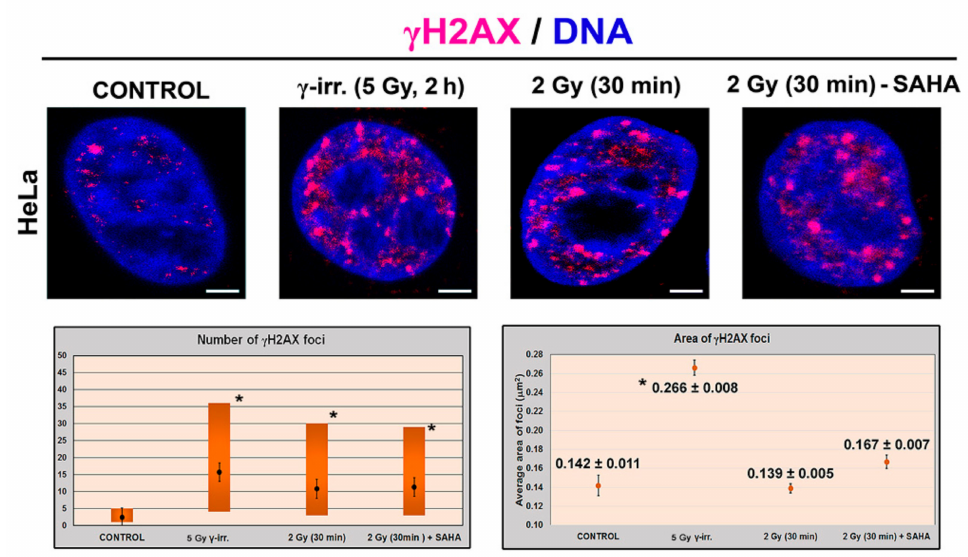
Figure 9. E ff ects of γ -irradiation by 5 Gy of γ -rays, SAHA treatment, and a combination of 2 Gy with SAHA treatment. The number and area of γ H2AX-positive foci were measured. Data were compared with non-treated cells. Immunofluorescent data were quantified using the ImageJ software. Fluorescence intensity (FI) was analyzed, and foci with FI ≥ 100 were used for analysis. Number of repair foci are shown as a minimal and maximal value, and area of γ -positive foci is shown as mean ± standard errors (S.E.). Asterisks show statistically significant results at p ≤ 0.05. Student’s t-test was used for statistical analysis. Scale bars show 5 µ